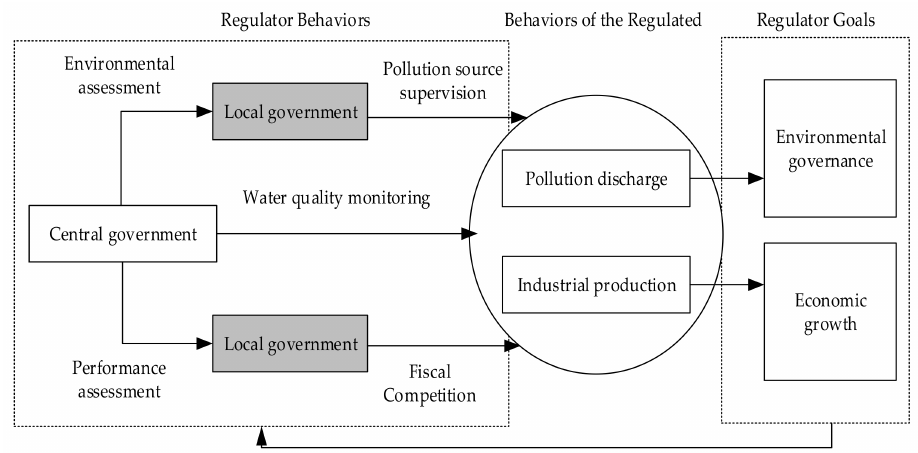
Figure 1. Analysis framework of regulators’